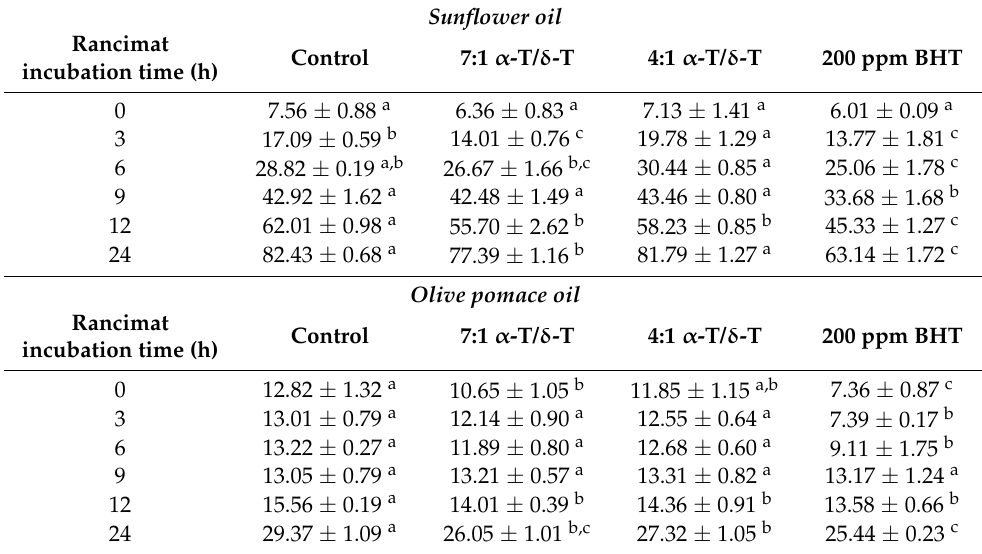
Table 5. Peroxide values (mmoL H 2 O 2 /Kg Oil ± SD) of sunflower oil and olive pomace oil samples. Inside rows with a specific superscript letter (e.g., a–c) indicate a significant ( p < 0.05) difference for each Rancimat incubation